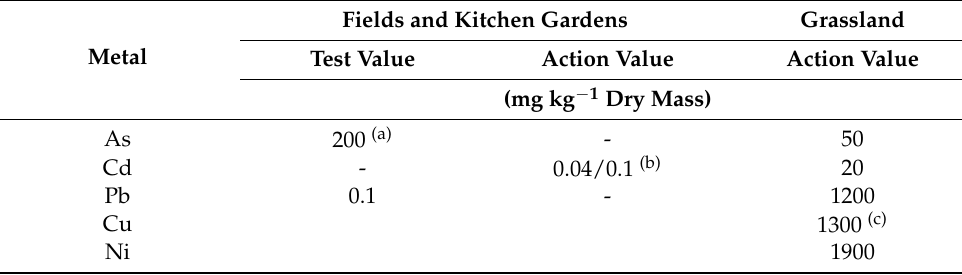
Table 4. Test and measure values for the pollutant transition from soil to crop on arable land and in